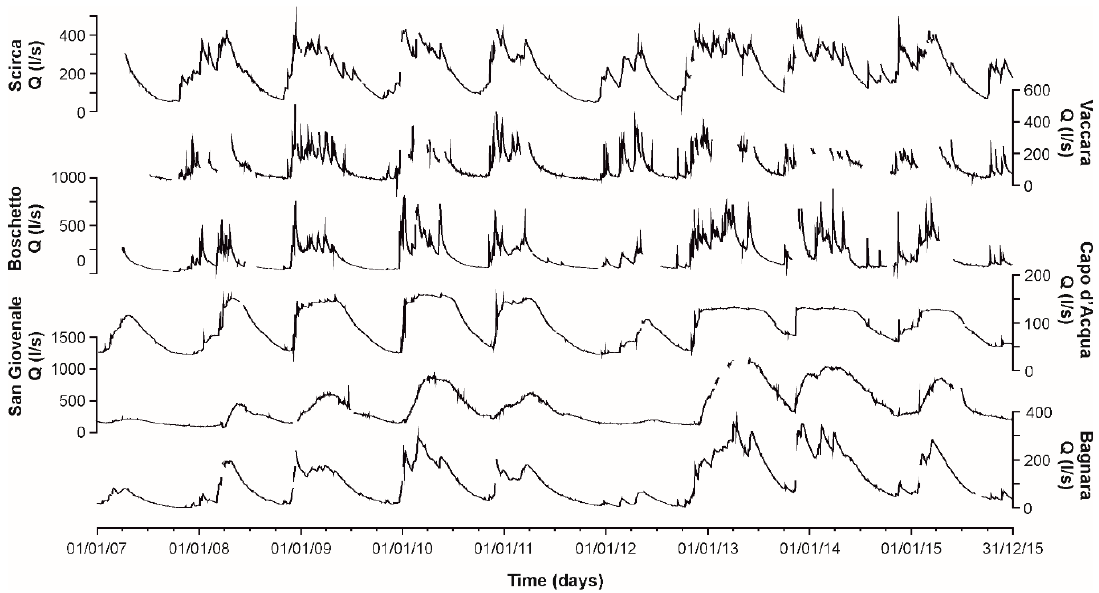
Figure 3. Discharge time series of the Umbria-Marche carbonate springs (data from ARPA Umbria). Table 3. General characteristics of the time-series of the analyzed aquifer springs.